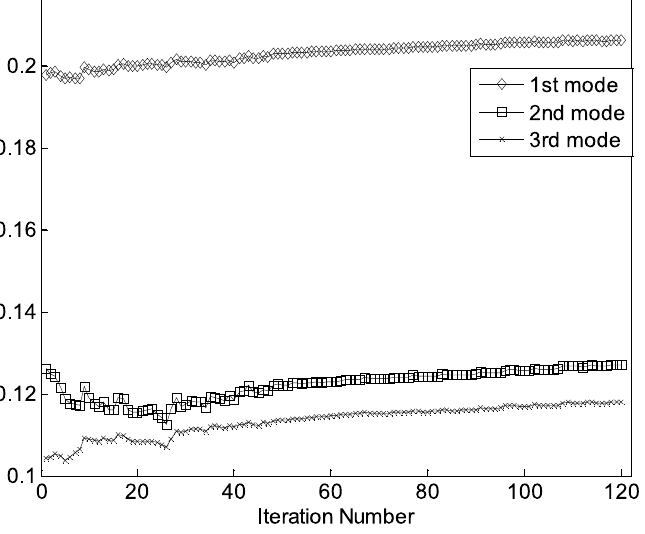
Fig. 12. Iteration histories for different modes vf =